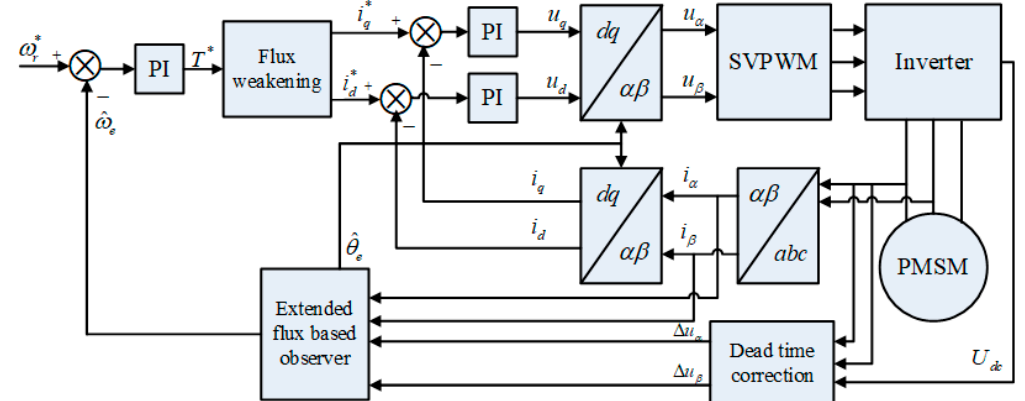
Figure 7. Structure of the extended flux-based sensorless control system with dead-time correction.